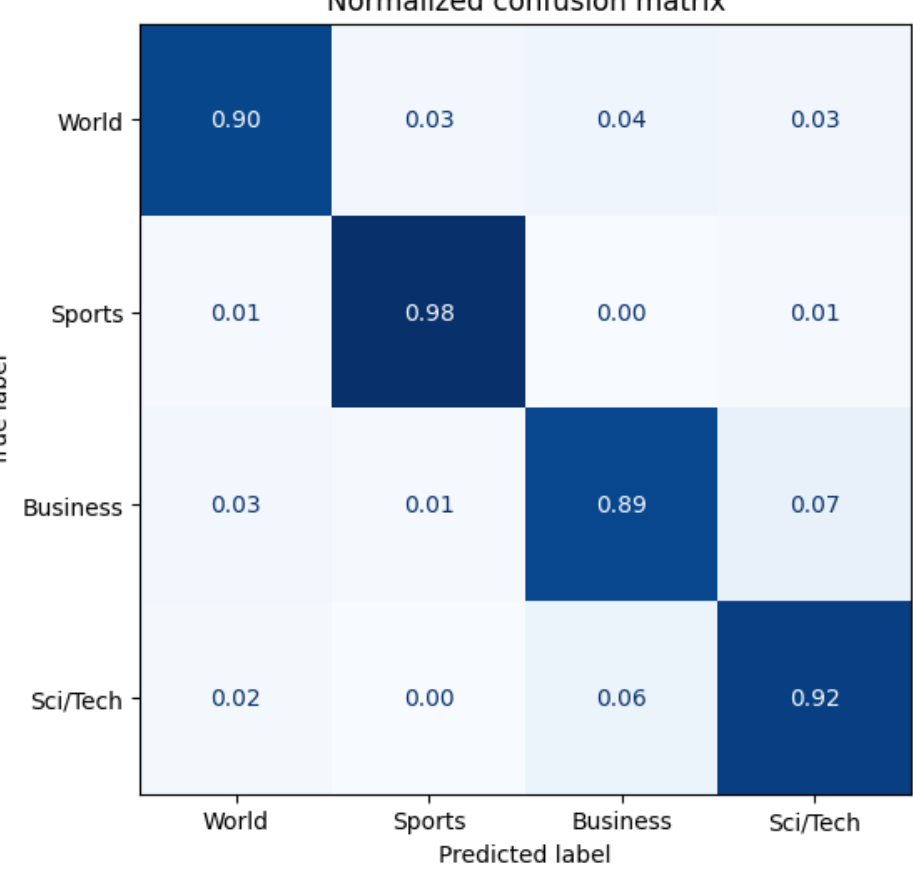
Figure 14. Antipode3 Run1 Confusion Matrix on AG-News.